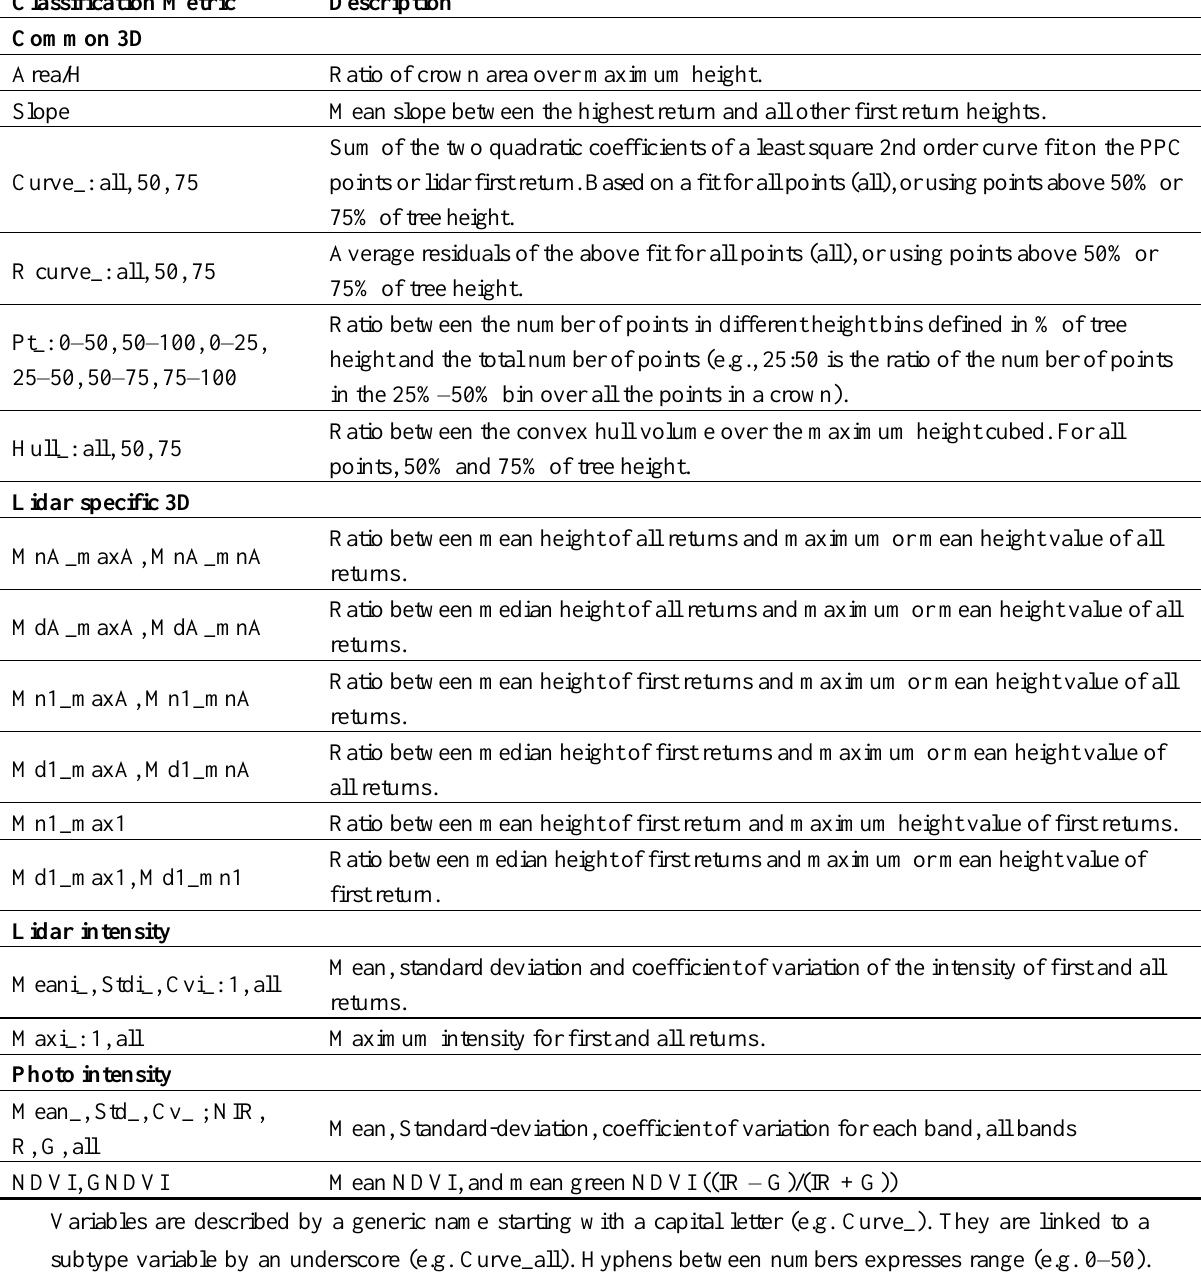
Table 4. List of metrics used in classification, listed per